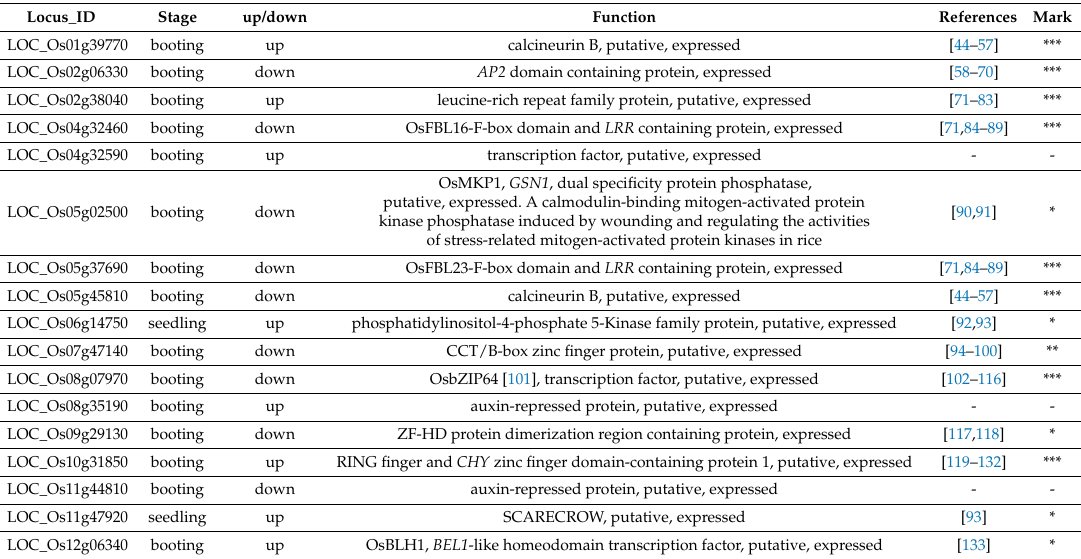
Table 5. List of candidate key genes responding to the